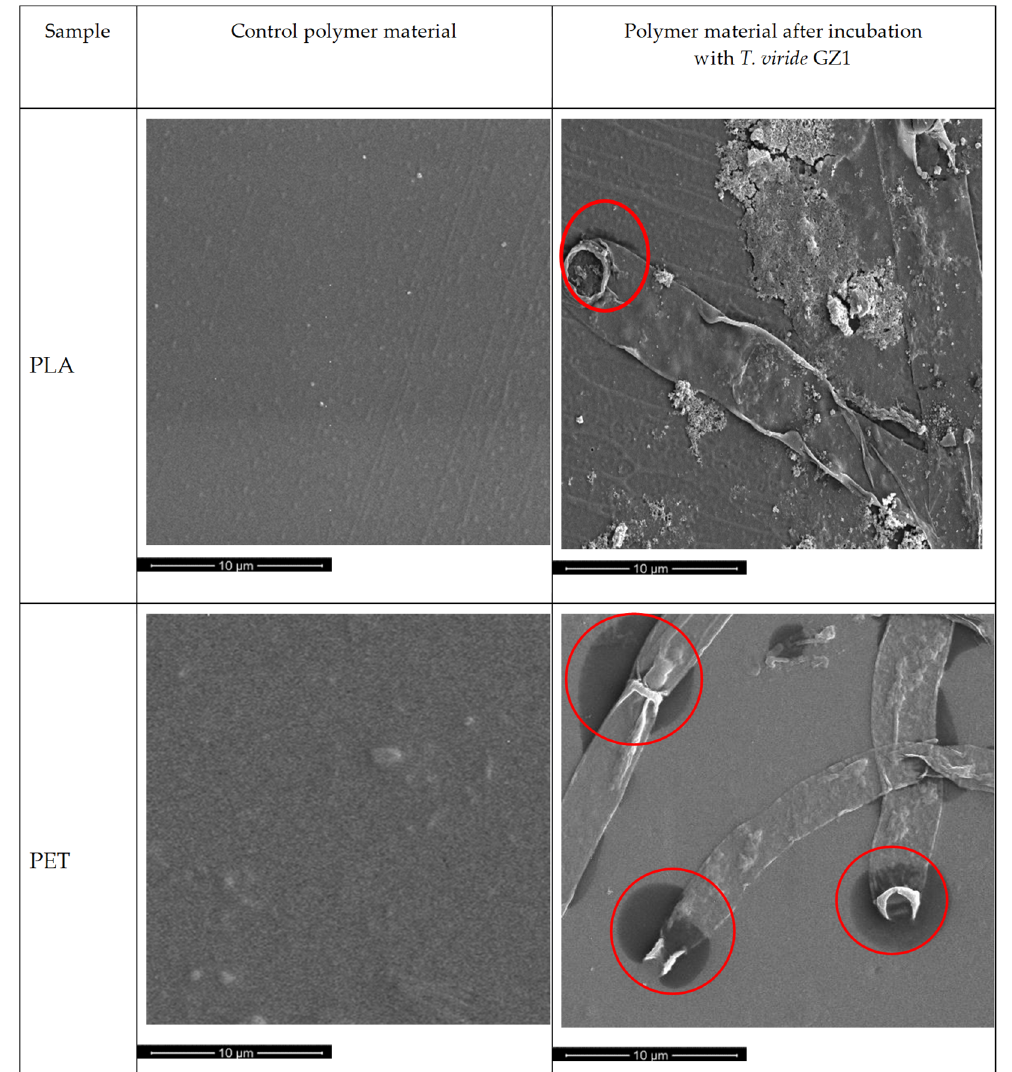
Figure 1. SEM analysis (magnification 10,000 × ) of the polymer materials after 3-month incubation in liquid medium: the left-hand side shows polymers incubated without fungus (control), and the right-hand side shows polymers incubated with T. viride GZ1. Red circles indicate spots where the release of the cytoplasmic content of hyphae takes place.